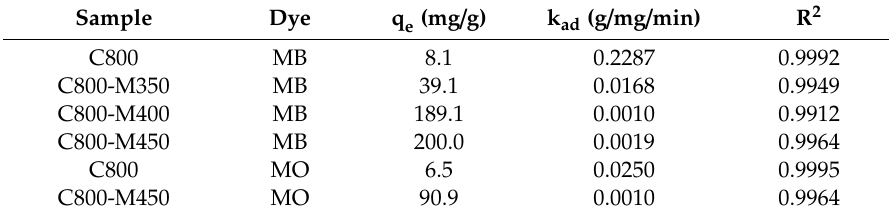
Table 5. Regression results from pseudo-second-order kinetic